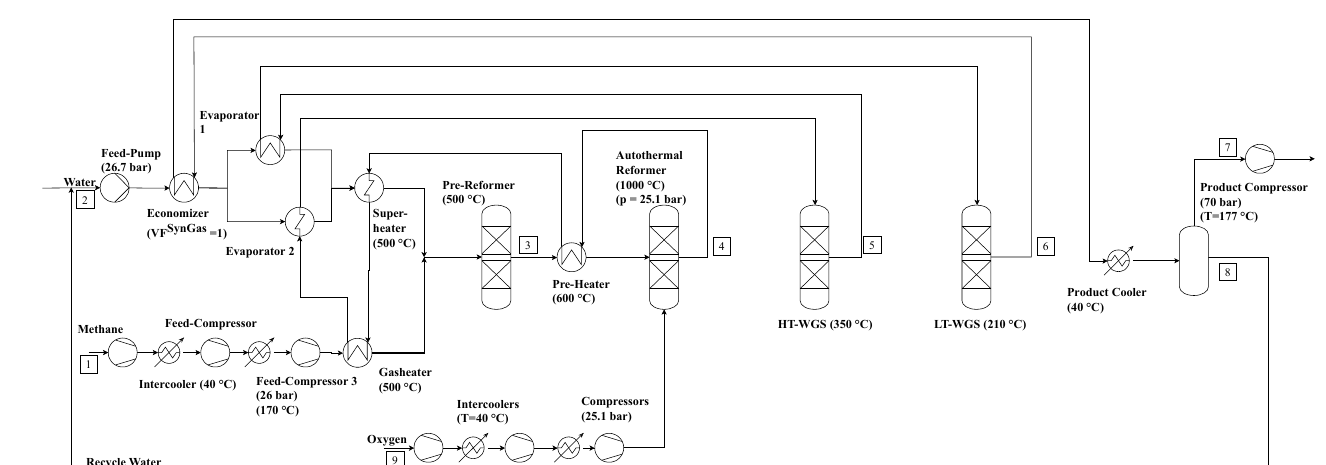
Table 3 . The key parameters as well as literature references for the ATR design are pro- vided in Table 4.